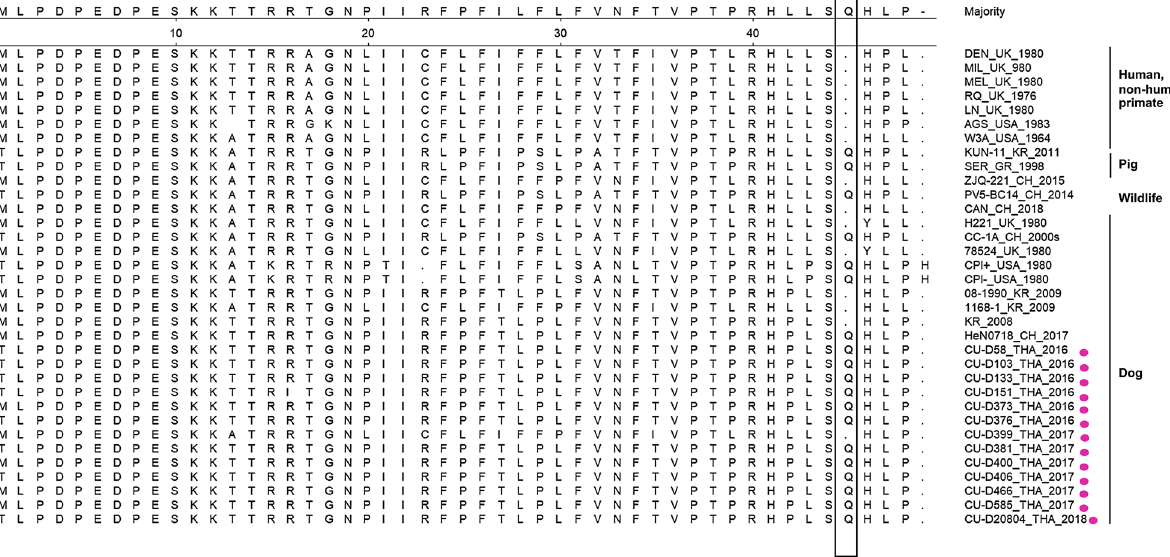
Figure 3. Alignment of deduced amino acids of the SH gene of Thai CPIV-5 and reference PIV-5 viruses. The box indicates amino acid substitution at the stop codon (Q). Pink circles indicate Thai CPIV-5 in this